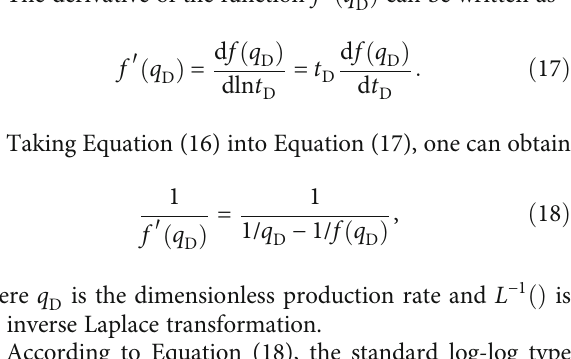
t D for a homogenous D ) vs.